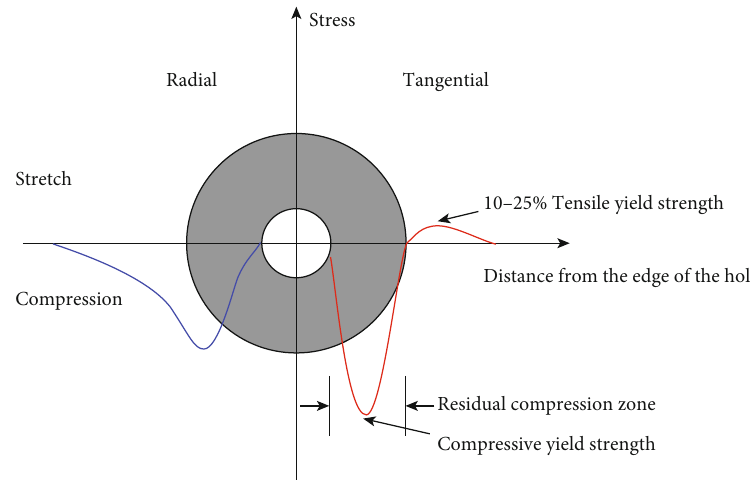
Figure 2: Residual stress distribution after